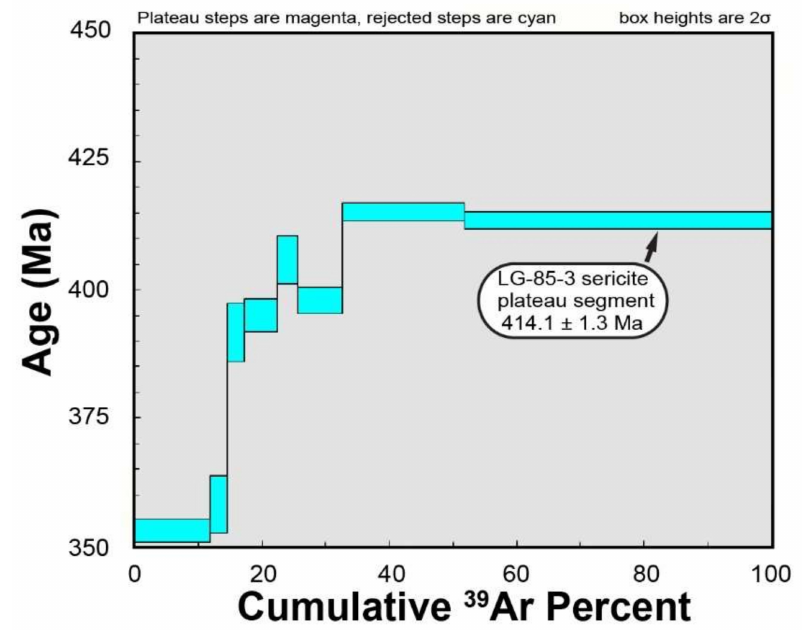
Figure 22. 40 Ar/ 39 Ar age spectrum of hydrothermal muscovite separate from the sericitic alteration envelope surrounding the gold-bearing quartz–carbonate veins from sample LG-85-3.